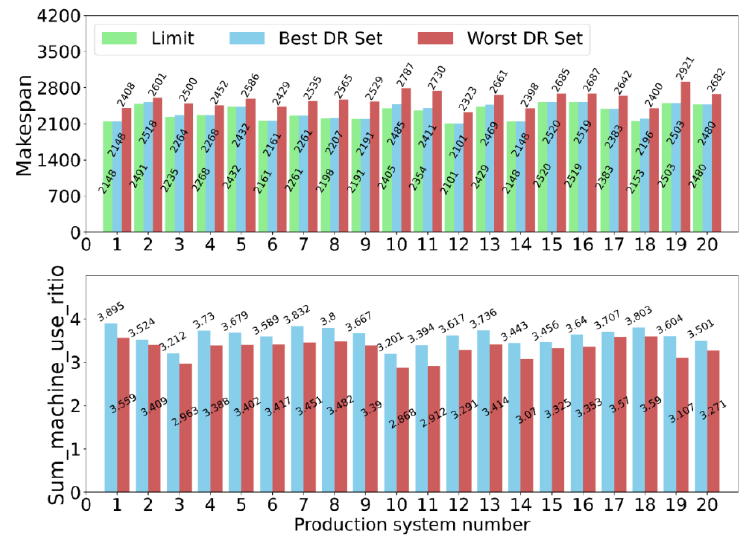
Figure 6. Low job heterogeneity and a high manufacturing system load rate.